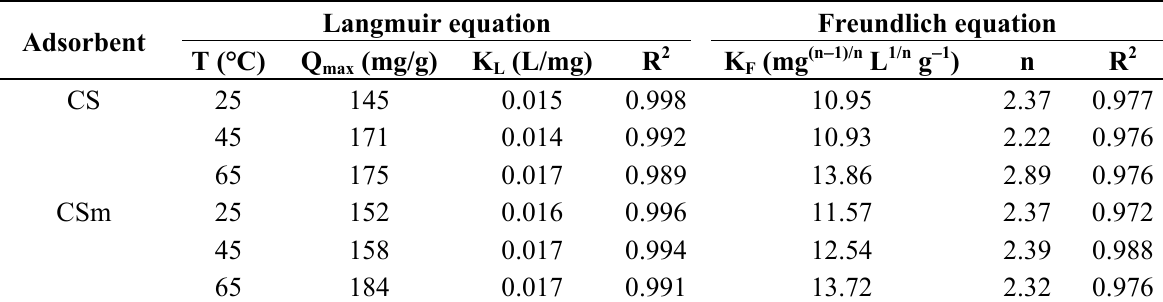
Table 3. Equilibrium parameters for the adsorption of Hg(II) onto CS and CSm at 25, 45 and 65